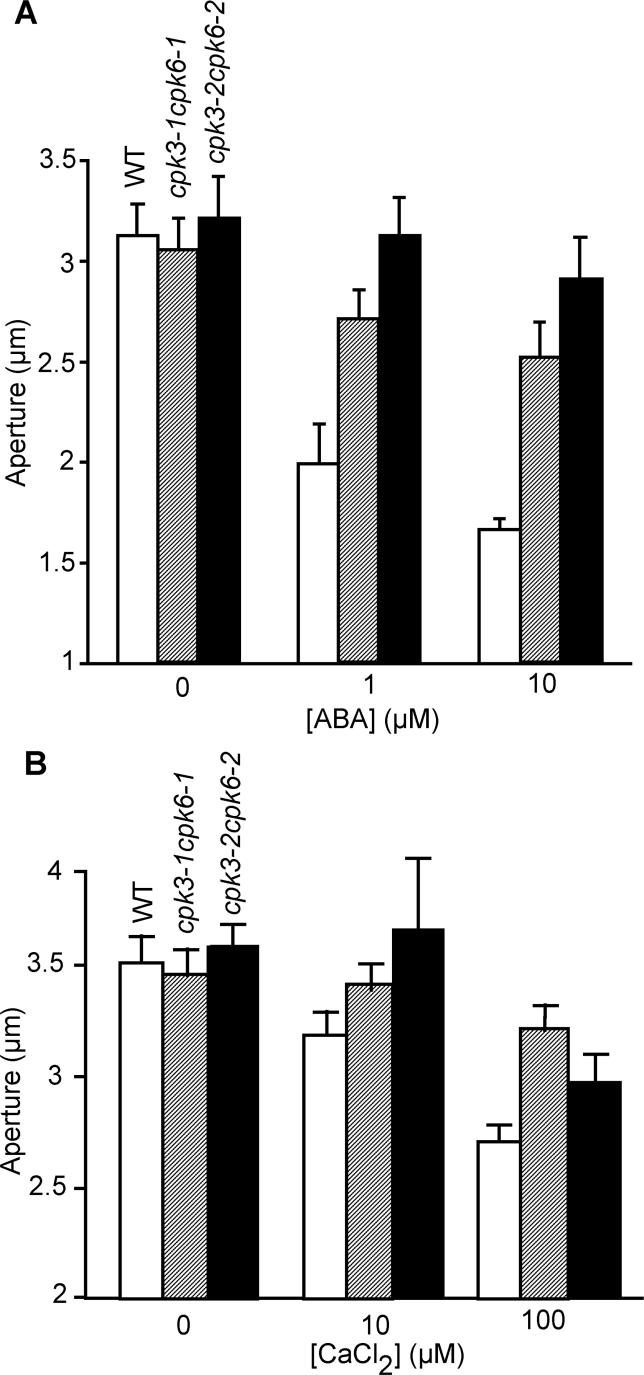
ABA- and Ca2+-Induced Stomatal Closure Is Partially Impaired in cpk3cpk6 Mutants(A) ABA-induced stomatal closing (white bars: wild-type; shaded bars: cpk3-1cpk6–1 double mutant; black bars: cpk3-2cpk6–2 double mutant). Average data from representative experiments are shown (wild-type: WT, n = 13 experiments, 260 total stomata; cpk3-1cpk6–1 double mutant: n = 7 experiments, 140 stomata; cpk3-2cpk6–2 n = 4 experiments, n = 120 stomata).(B) External Ca2+-induced stomatal closing (white bars: wild-type, shaded bars: cpk3-1cpk6–1 double mutant, black bars: cpk3-2cpk6–2 double mutant). Average data from representative experiments are shown (wild-type: WT, n = 9 experiments including 4 blind experiments, 180 total stomata; cpk3-1cpk6–1 double mutant, n = 9 experiments including 4 blind experiments, 180 total stomata; cpk3-2cpk6–2, n = 4 experiments, n = 80 stomata). Stomatal aperture widths are illustrated. Error bars represent SEM.